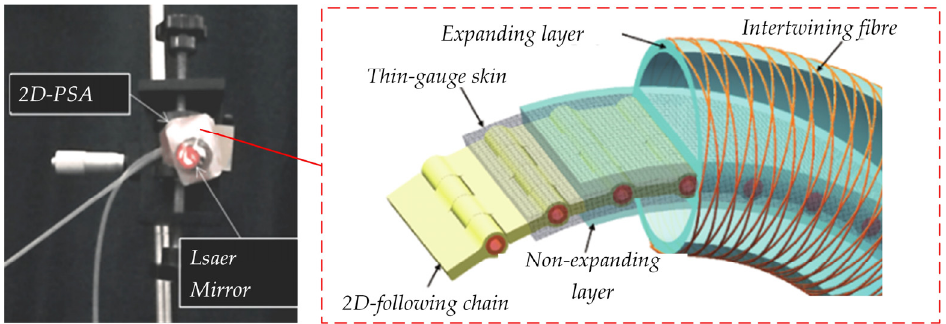
Figure 8. Structural characteristics of the 2D-PSA.